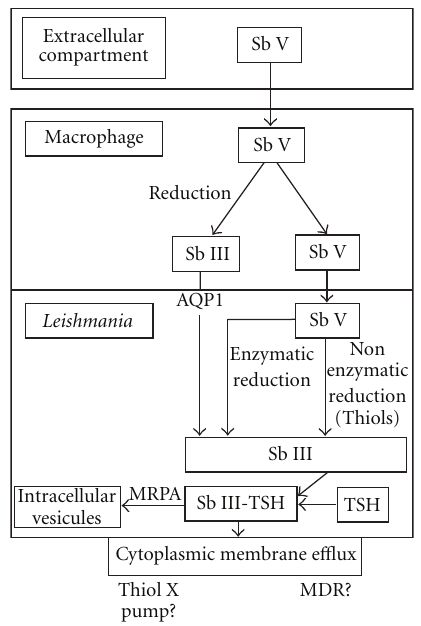
Figure 2: Antimony metabolism and transport inside macrophage and Leishmania. SbV: pentavalent antimony, SbIII: trivalent anti- mony, AQP1: acquaglyceroporine 1, TSH: trypanothione, MRPA: multidrug related protein A, MDR: multidrug